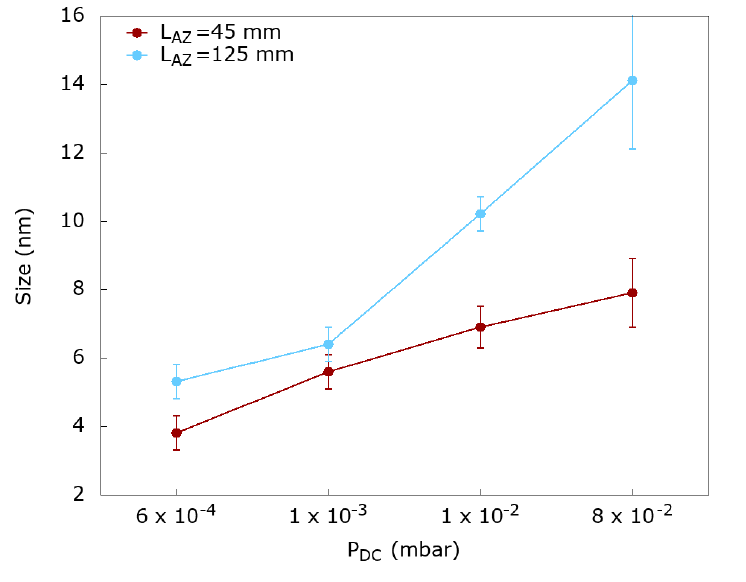
Figure 2. Evolution of the NPs size in function of the P DC at two different L AZ .